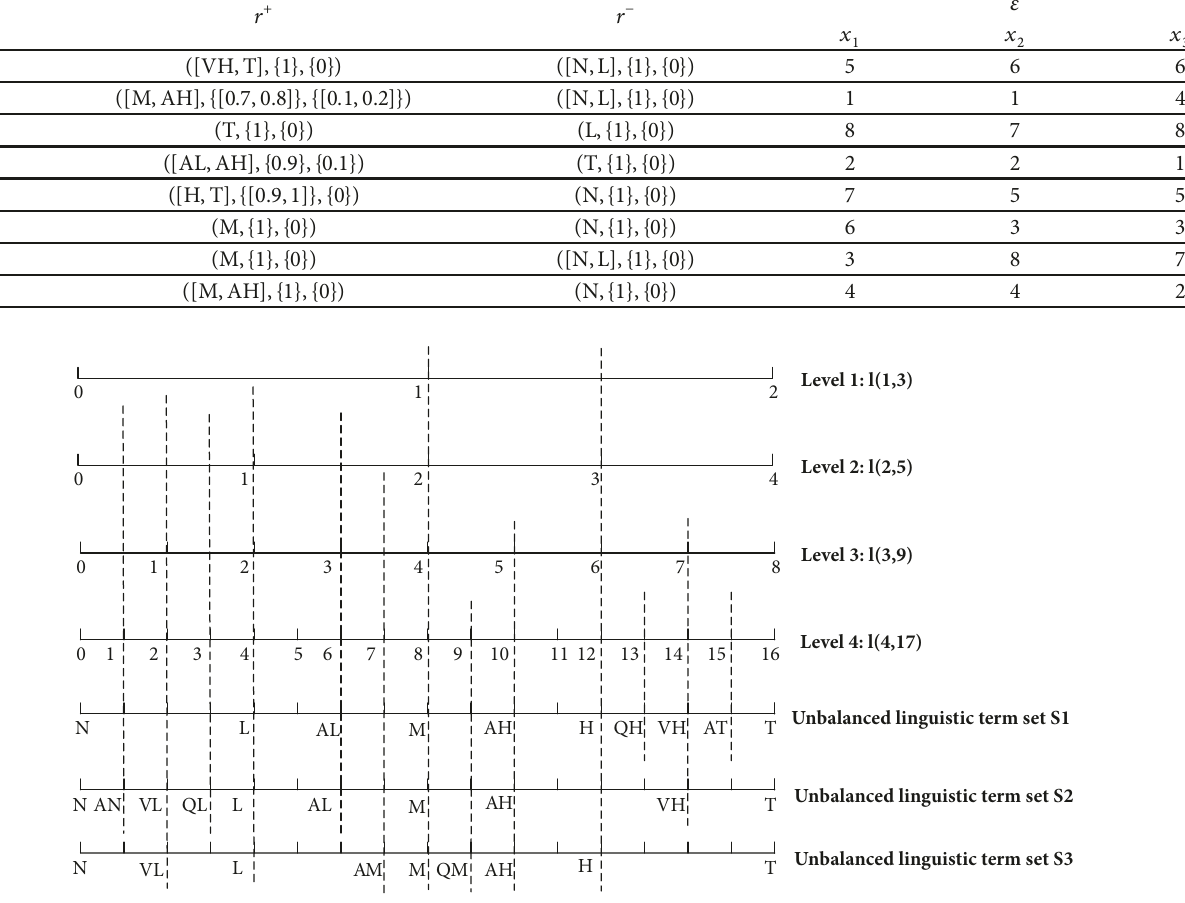
Figure 4: Unbalanced linguistic term sets ( 𝑆 1 ,𝑆 2 , and 𝑆 3 ) and their mapping in linguistic hierarchies.